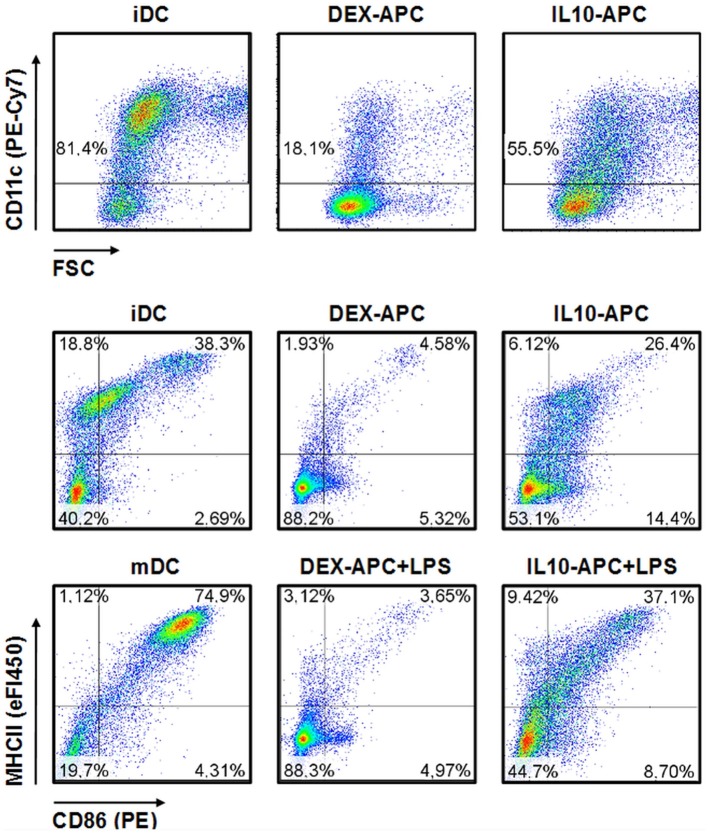
Immuno-phenotype of differentially tolerized APC populations. APC populations were generated as described in the Materials and Methods section, and surface expression of the DC lineage marker CD11c and of the activation markers MHCII and CD86 at unstimulated state and after stimulation with LPS were assessed by flow cytometry. Graphs shown are representative for 2 independent experiments each.